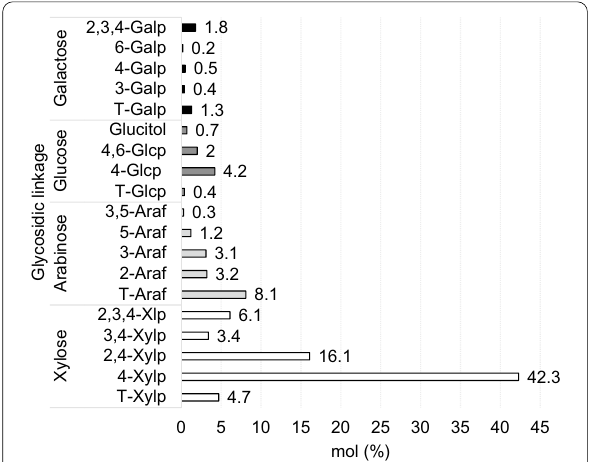
Fig. 1 Carbohydrate composition of GAX fraction obtained by extraction of BSG with 4 M KOH